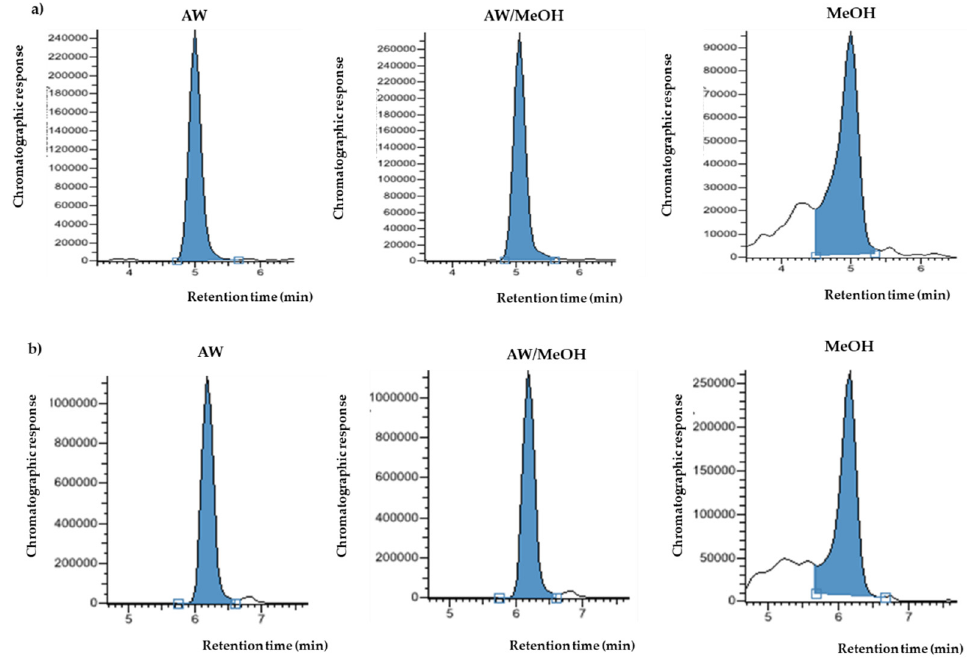
Figure 3. Peak shape comparison standard solutions (200 µg L − 1 ) prepared in AW, AW/MeOH and MeOH for: ( a ) protocatechualdehyde; ( b ) chlorogenic acid.